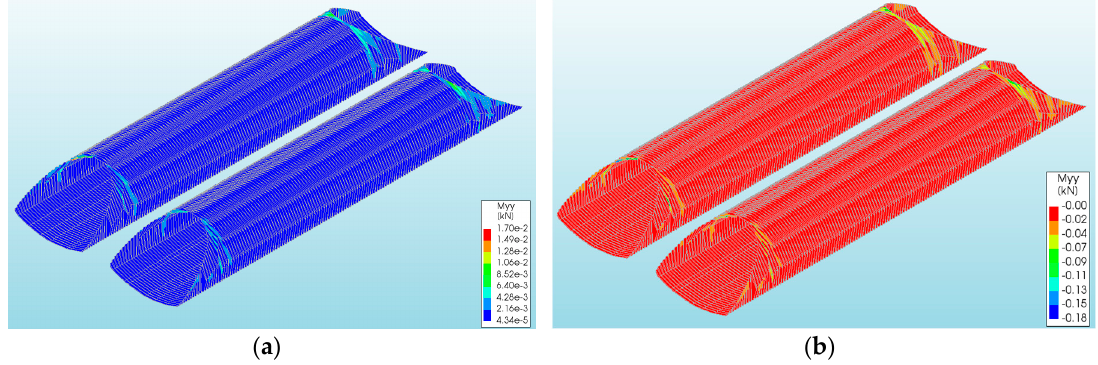
Figure 9. Maximal values of bending moments of: ( a ) Rockburst for model Ia, ( b ) El Centro for model Ib.